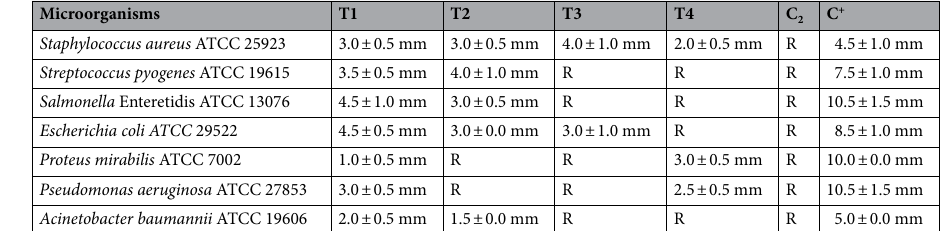
Table 3. Inhibitory activity of the triazene compounds against Gram-positive and -negative bacteria through the agar diffusion test using impregnated discs.